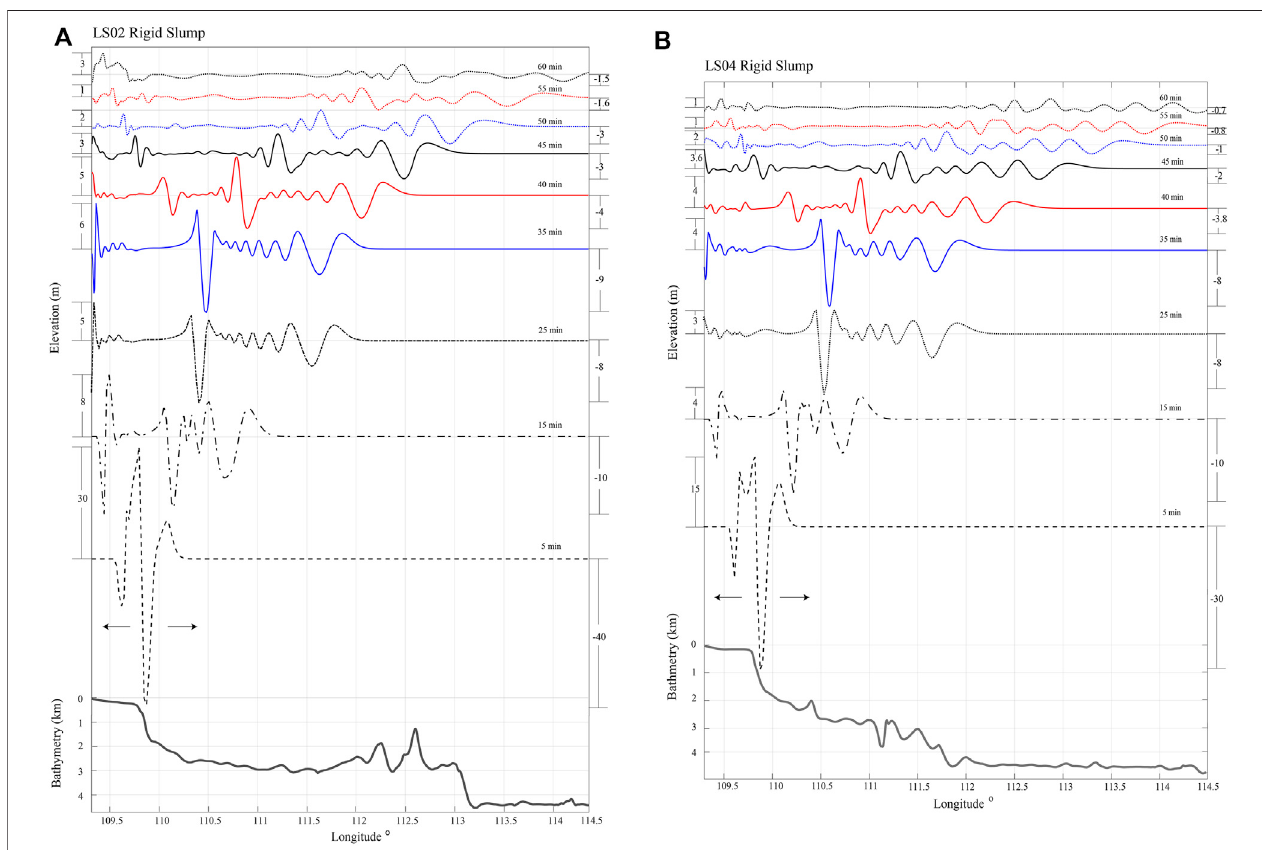
FIGURE7| Pro fi les oftsunami surfaceelevation generated byrigidslumpsof (A) :LS02 (CC ′ ) and (B) : LS04(DD ′ )at t=5,15, 25,35, 40,45,50,55,60 min. Black arrows : the propagation direction of tsunami wave.